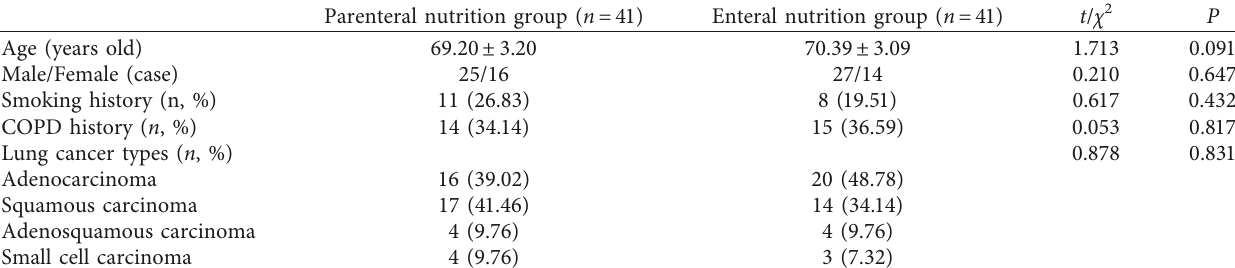
Table 1: Comparison of general data between two